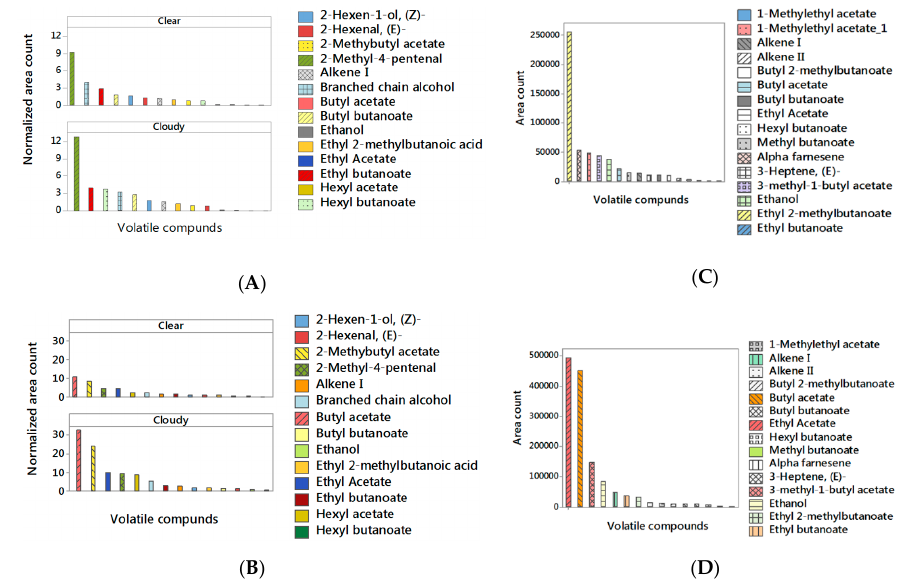
Figure 3. The relative abundance of volatile compounds identified in fresh, clear, and cloudy apple juices from McIntosh ( A ) and Honeycrisp ( B ) apples, as well as from whole McIntosh ( C ) and Honeycrisp ( D ) apples stored for 4 months under controlled atmosphere (CA) or regular atmosphere (RA) conditions and harvested at commercial or late maturity stage. The value for each bar represents the mean of 48 samples each with three biological replicates.